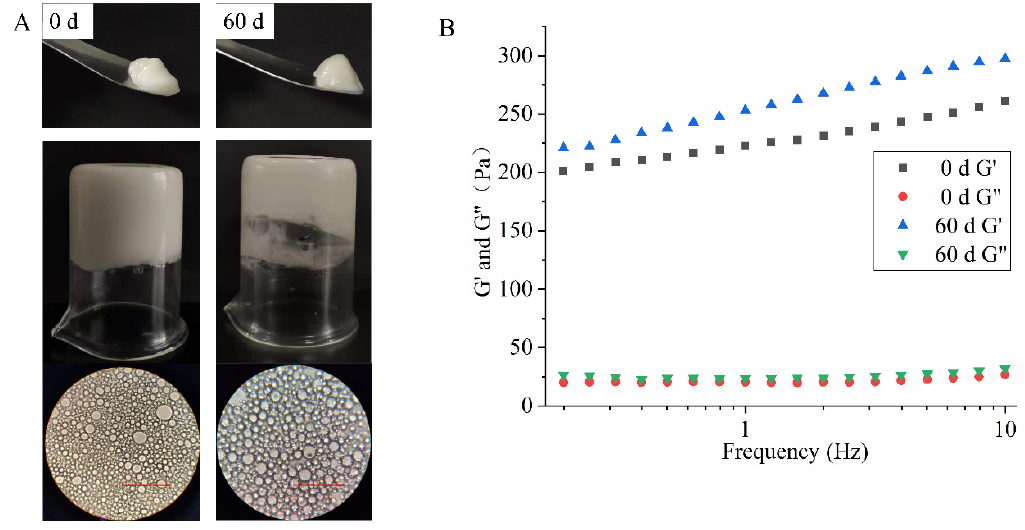
Figure 10. Visual appearance, microstructure ( A ), and frequency sweeps ( B ) of HIPEs stabilized by 3.0 wt% EYGs at NaCl ionic strength of 0.3 M before and after 60 days. The ϕ is 0.8. The corresponding 3.0 wt% EYGs at NaCl ionic strength of 0.3 M before and after 60 days. The φ is 0.8. The corresponding bar is 100 µm. bar is 100 µ